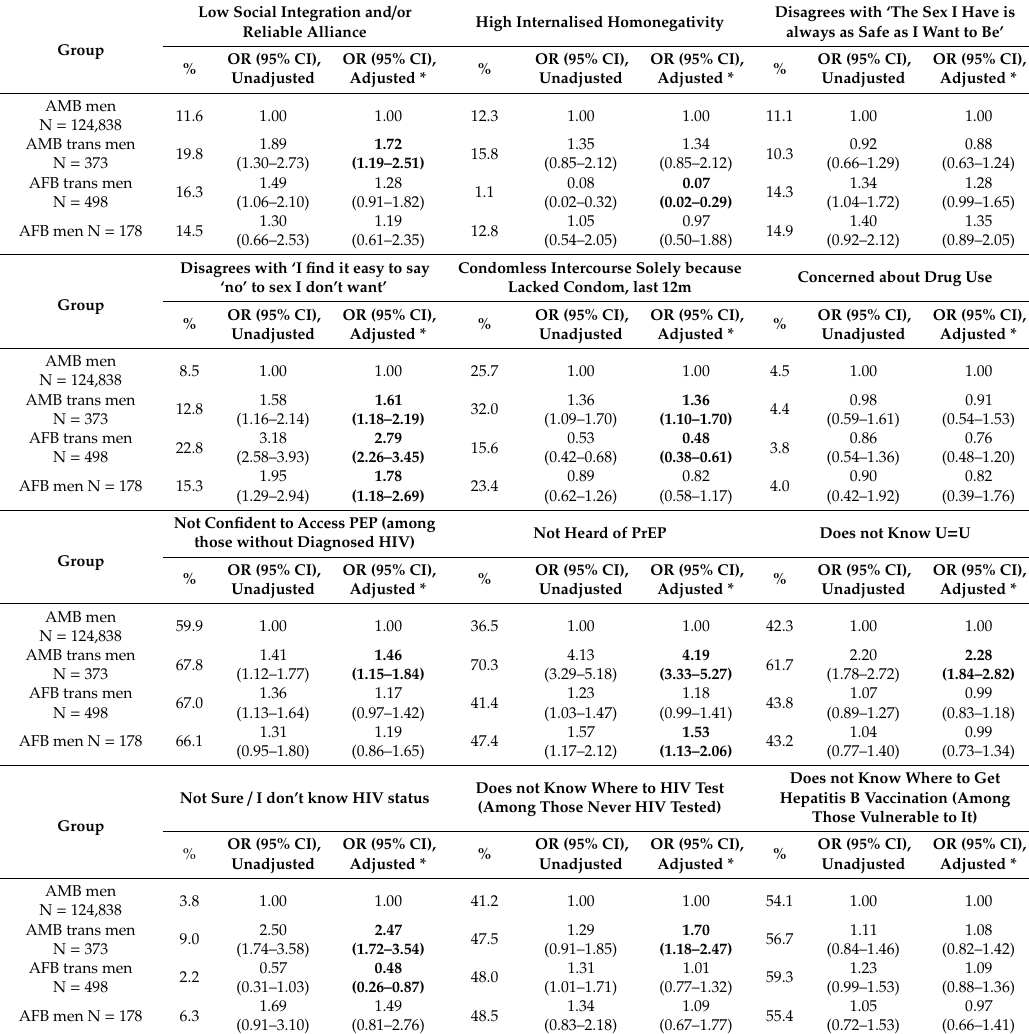
Table 4. Indicators of unmet health promotion need across four sex-assigned-at-birth / current -gender-identity subgroups of